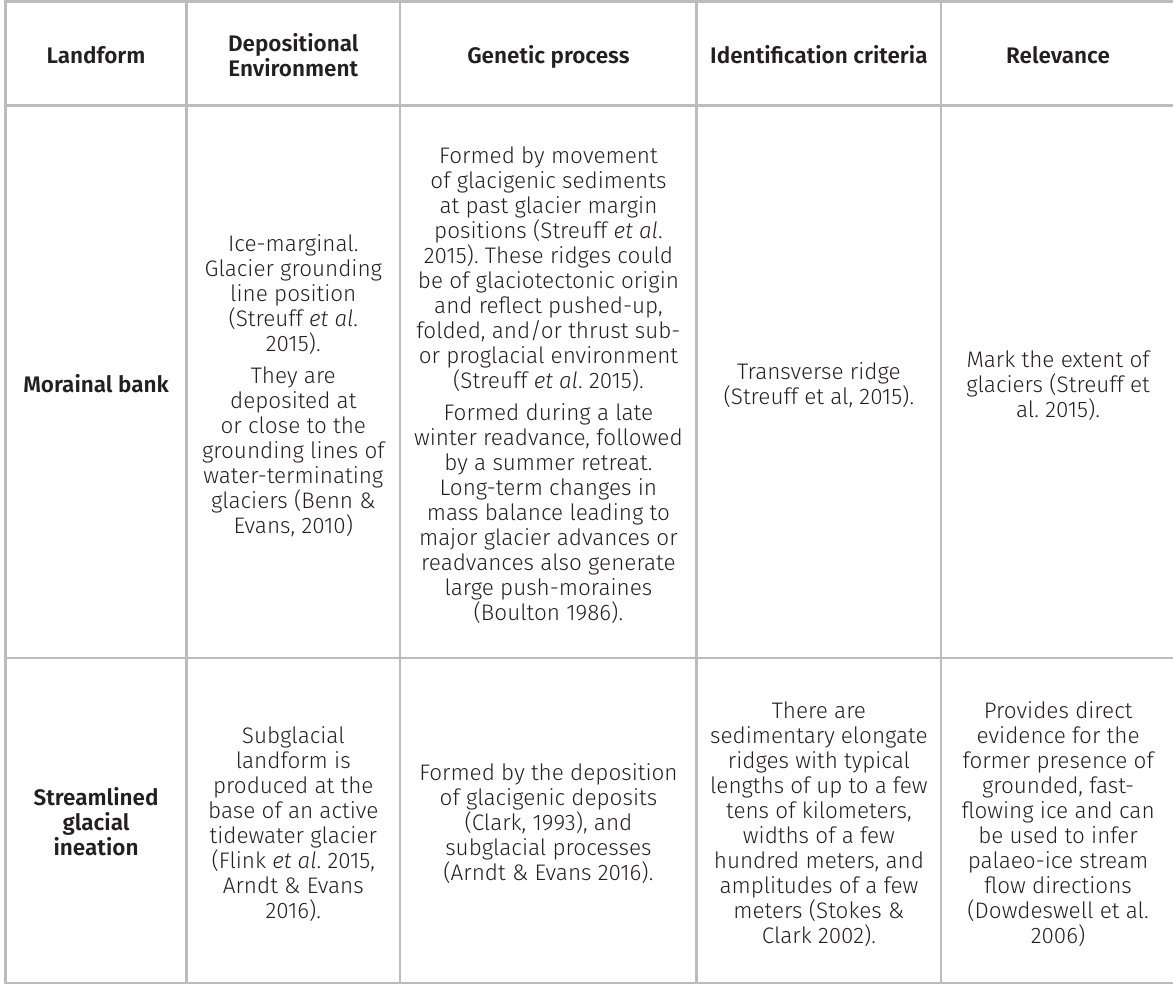
Table I. Criteria for glacial submarine landforms identification.